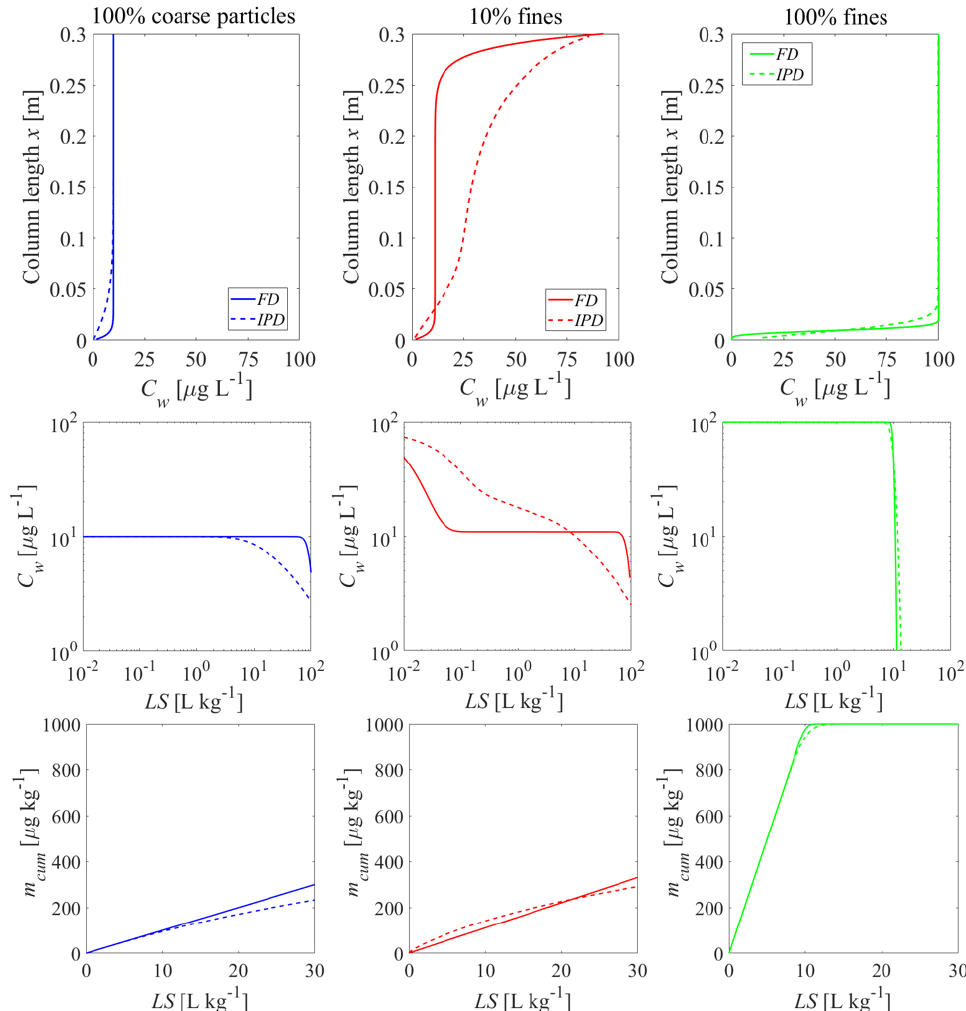
Figure 11. Behavior of bi-modal material compositions of fine particles with low sorption capacity ( K d = 10 L kg − 1 ) and coarse particles with high sorption capacity ( K d = 100 L kg − 1 ): initial con- centration distributions in the column after the first flooding ( top panel ) and the column effluent concentration (normalized: mid panel , cumulative: bottom panel ) vs. time (expressed as liquid to solid ratio: LS ). Left column: 100% coarse particles; mid column: mixed sample with 10% fine particles; right column: 100% fine particles; n = 0.45, v = 1.67 × 10 − 5 m s − 1 , α = 0 (no dispersion), C s , ini = 1000 µ g kg − 1 , t c = 5 h, D aq = 1 × 10 − 9 m 2 s − 1 , ε = 0.05, d p , coarse = 2000 µ m, d p , fine = 63 µ